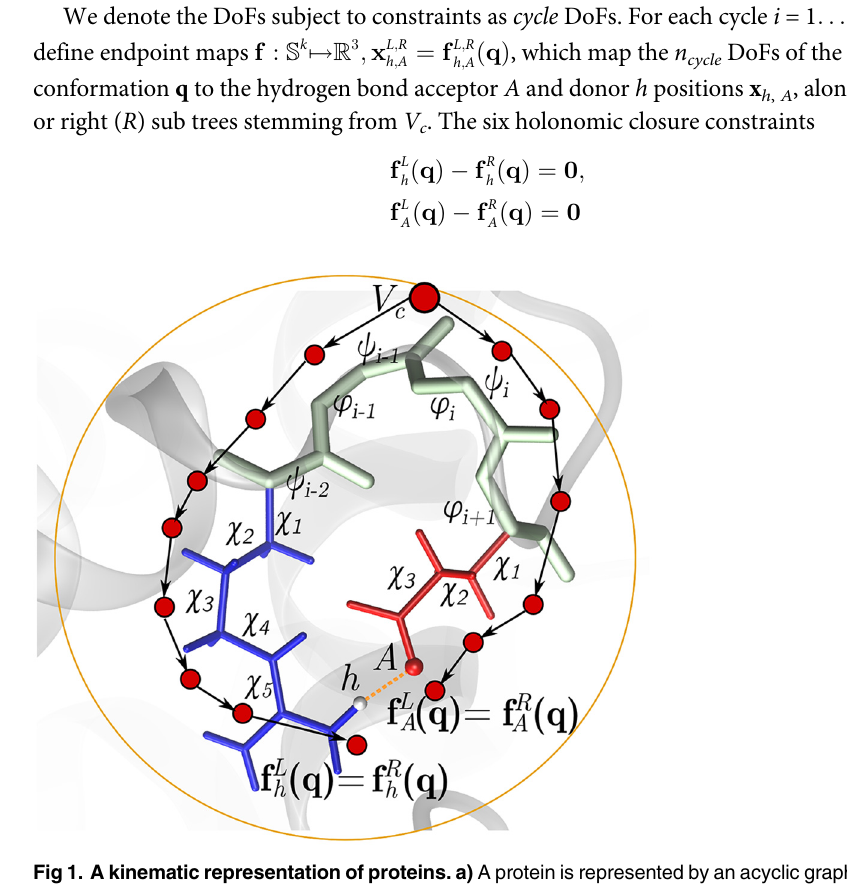
Fig 1. A kinematic representation of proteins. a) A protein is represented by an acyclic graph G = ( V , E ) encoding a kinematic chain. A hydrogen bond h – A defines a distance constraint, which results in a closed loop. A perturbation to the position of h by DoFs along the subtree on the left side needs to be matched by a perturbation to h by DoFs on the right side. Similarly for the position of A .